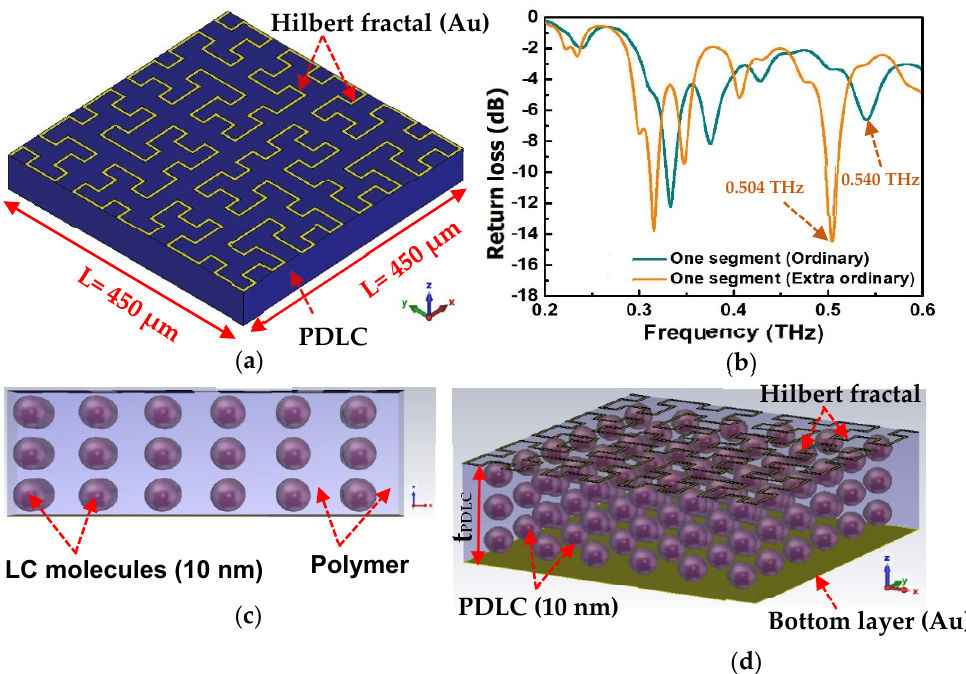
Figure 5. ( a ) One segment unit cell antenna and ( b ) return loss of the proposed antenna from extraordinary to ordinary polarization in the PDLC. Continuous frequency tuning using dielectric changed using ferroelectric material (PDLC). Here, frequency shifts are due to liquid crystal changes from the ordinary to extraordinary state. ( c ) Side view and ( d ) 3D perspective view of the unit cell antenna. The thickness of the PDLC is t PDLC = 50 µ m, with a liquid crystal size of 10 nm. The top Hilbert fractal (au) and the bottom metal (Au) thickness is 200